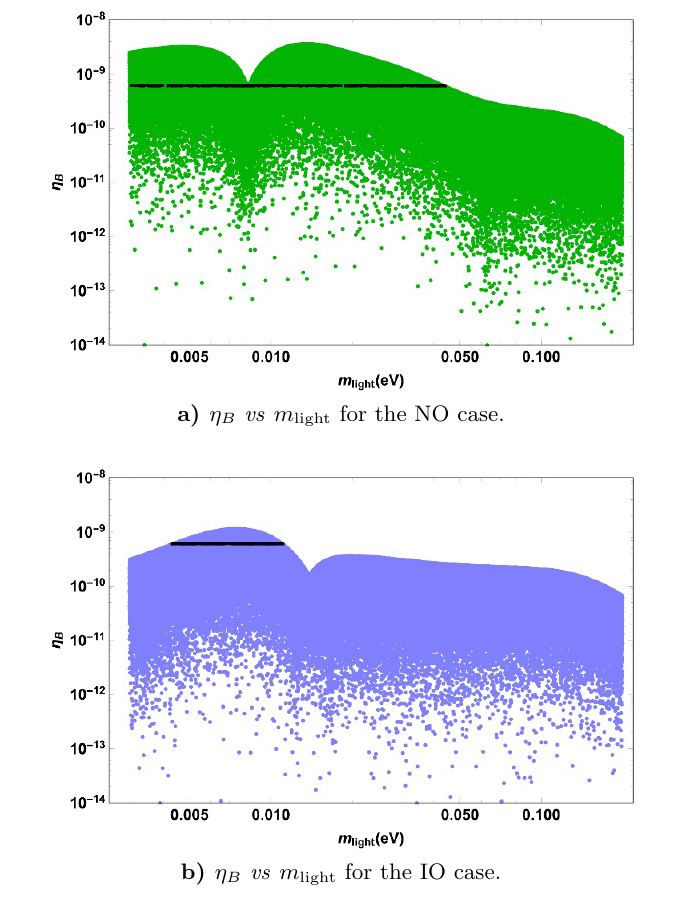
Figure 4 . (cid:17) B as a function of the lightest neutrino mass for the NO on the top and IO on the bottom. In black the points where (cid:17) B falls inside its experimental determination at 3 (cid:27) error. Charged lepton masses and neutrino oscillation parameters have been taken at their central value as in table 1, 0 : 01 . z < 20, c 1 = c 2 = 0 : 01 and the Majorana CP phases randomly vary in their